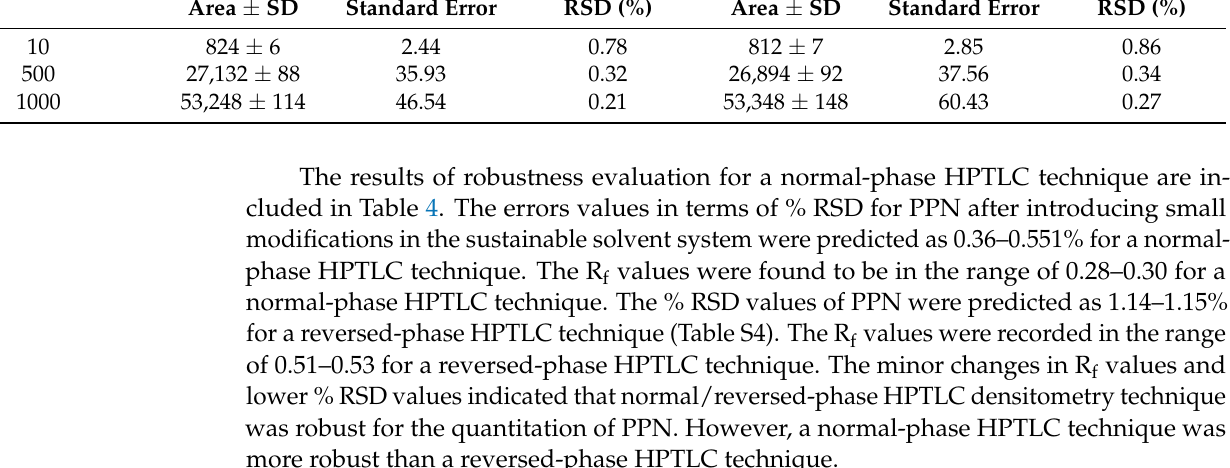
Table 3. Results of precision evaluation for normal-phase HPTLC technique (mean ± SD; n = 6). Conc. (ng Band − 1 )